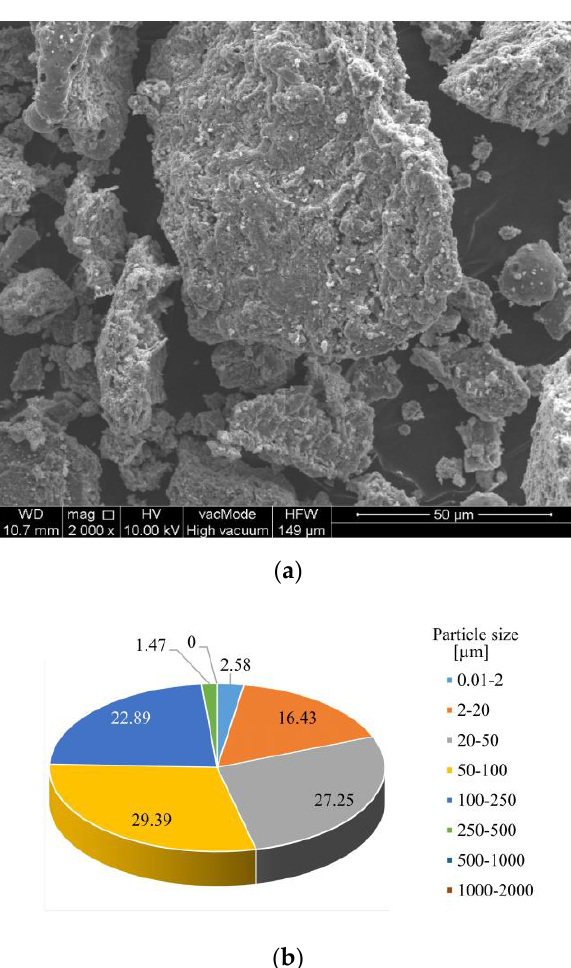
Figure 3. SEM image ( a ) and volumetric distribution of individual fractions in the tested fly ashes ( b ). It was observed that the fly ash samples were dominated by irregular grains with variable size cuboidal forms were very